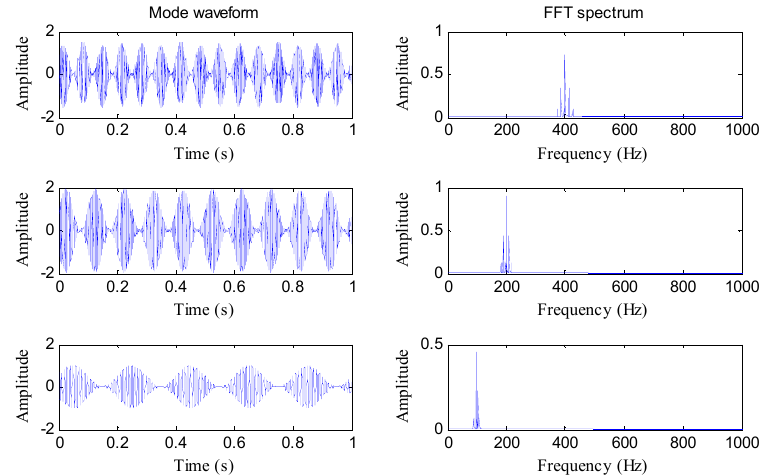
Figure 14. The decomposition results obtained by IAVMD for simulation 2 and their corresponding FFT spectrum. Figure 15. The time-frequency representations obtained by IAVMD for simulation 2: ( a ) Two-dimensional and ( b ) three-dimensional.